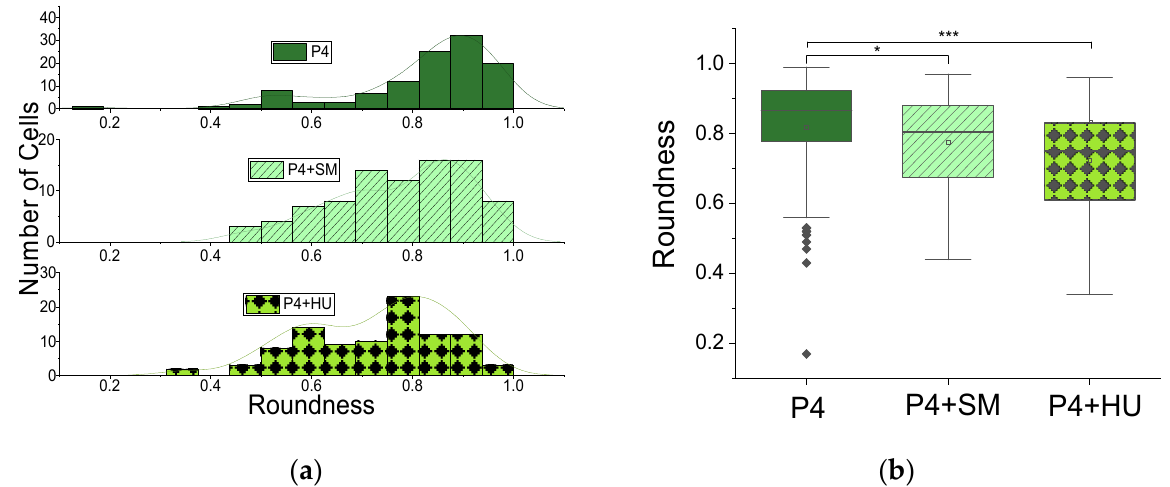
Figure 4. Morphometry of cells from MMM outlet: roundness. ( a ) Histogram of roundness (Equation (2)) and kernel smooth curves for RBCs from patient 4, showing morphological heterogeneity in untreated cells, P4; in cells treated with sodium metabisulfite, P4 + SM; and cells treated with hydroxyurea, P4 + HU. ( b ) Box plots for the roundness data in ( a ). Cell numbers ( n ) and roundness ( R ) for each condition are: P4, n = 114, R = 0.61 ± 0.02; P4 + SM, n = 88, R = 0.64 ± 0.02; and P4 + HU, n = 96, R = 0.50 ± 0.03. One-way ANOVA shows statistically significant (*** p < 0.001) differences between P4 and P4 + HU and (* p < 0.05) between P4 and P4 + SM. Again, the heterogeneity of RBC morphology in the same patient is made clear in Figure 4a, where the histogram of steady-state roundness, P4, has two peaks highlighted by the kernel smooth curve. Unlike circularity (Figure 3 and Equation (1)), roundness does not account for roughness of edges since it does not use the perimeter in its definition or calculation. It depicts the entire geometry of the object (cell). Here, it confirms the